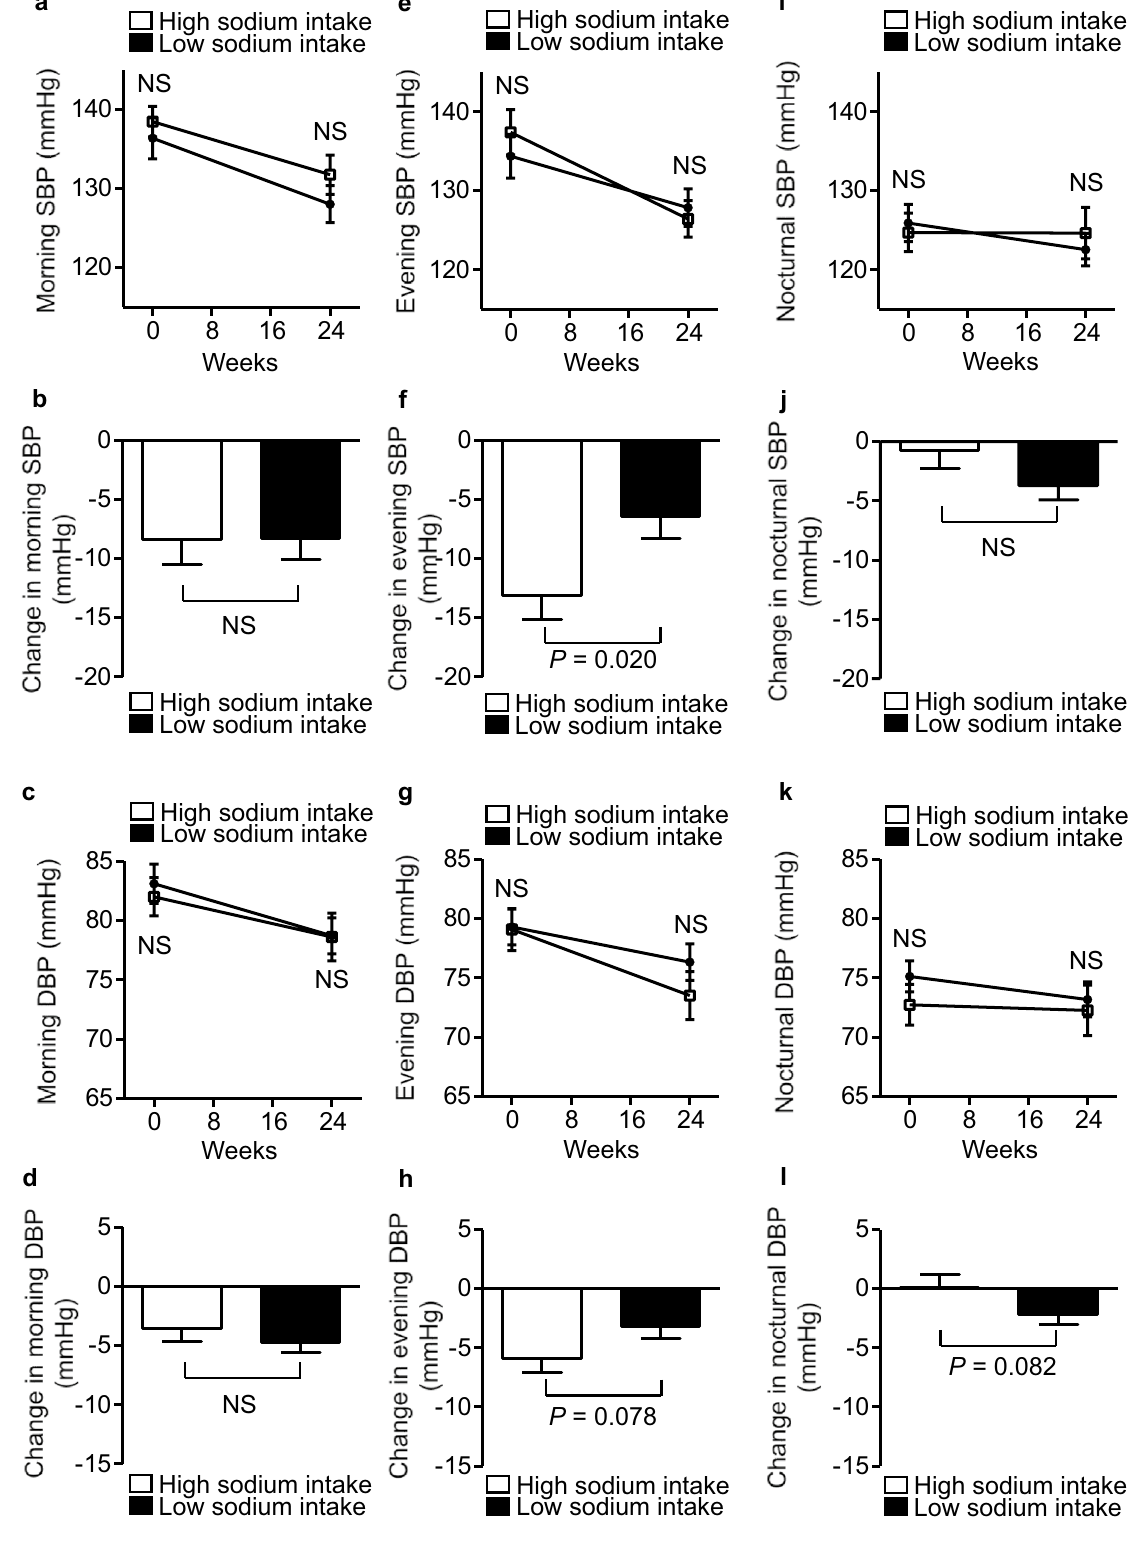
Figure 3. Effects of add-on dapagliflozin therapy on home-measured blood pressure in the HS and LS groups. Home blood pressure (BP) ( (a) morning systolic BP (SBP), (c) morning diastolic BP (DBP), (e) evening SBP, (g) evening DBP, (i) nocturnal SBP, and (k) nocturnal DBP) in dapagliflozin-treated patients during the 24-week study period. Change in home BP ( (b) morning SBP, (d) morning DBP, (f) evening SBP, (h) evening DBP, (j) nocturnal SBP, and (l) nocturnal DBP) during the 24-week study period. Eighty-four DKD patients were allocated to a high sodium intake (HS) group (open square) or a low sodium intake (LS) group (filled square), according to their median urinary sodium-to-creatinine ratio at baseline. Values are mean ± SE. The differences in the effects of dapagliflozin treatment between the two groups were analyzed using unpaired t -tests. NS, not